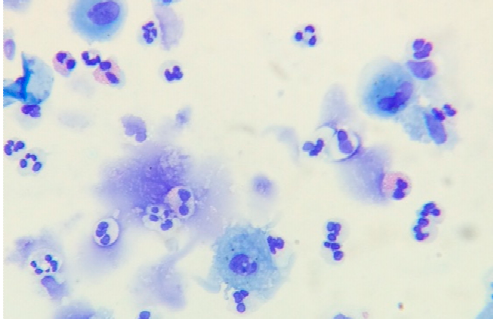
Figure 1. Sputum slide showing eosinophils.